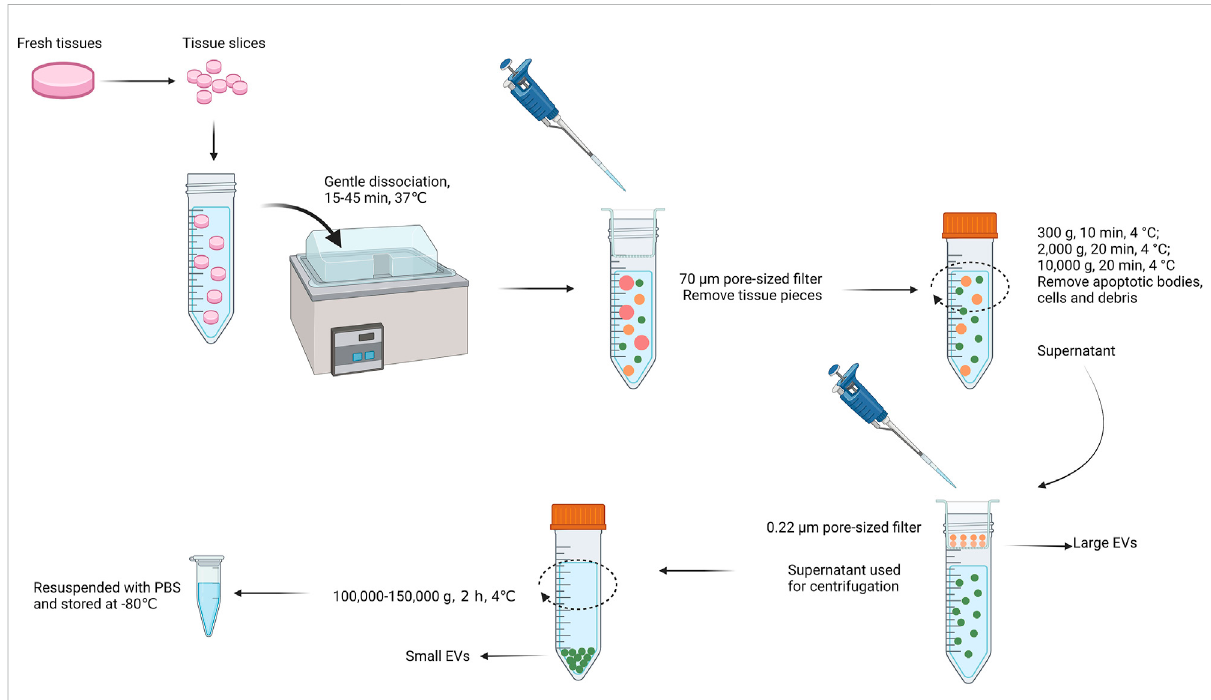
The promising universal method applied for extracting Ti-EVs from a variety of tissues. At fi rst, fresh tissues are sliced into slices and subsequently dissociated gently for 15 – 45 min at 37 ° C. Afterwards, a 70 μ m pore-sized fi lter is used to remove tissue pieces. Centrifugation at a speed of 300 – 10,000 g at 4 ° C is conducted to remove apoptotic bodies, remaining cells and debris and the supernatant pass through a 0.22 μ m fi lter to collect large EVs. Next, the fi ltrate is ultracentrifugated at a speed of 100,000 – 150,000 g at 4 ° C ( > 1 h) to collect small EVs. Finally, the isolated Ti-EVs are resuspended with PBS and can be stored at − 80 ° C for a long time.